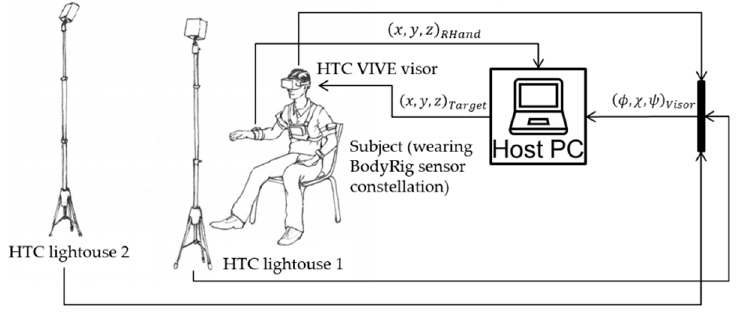
Figure 1. Block diagram and illustration of the setup.